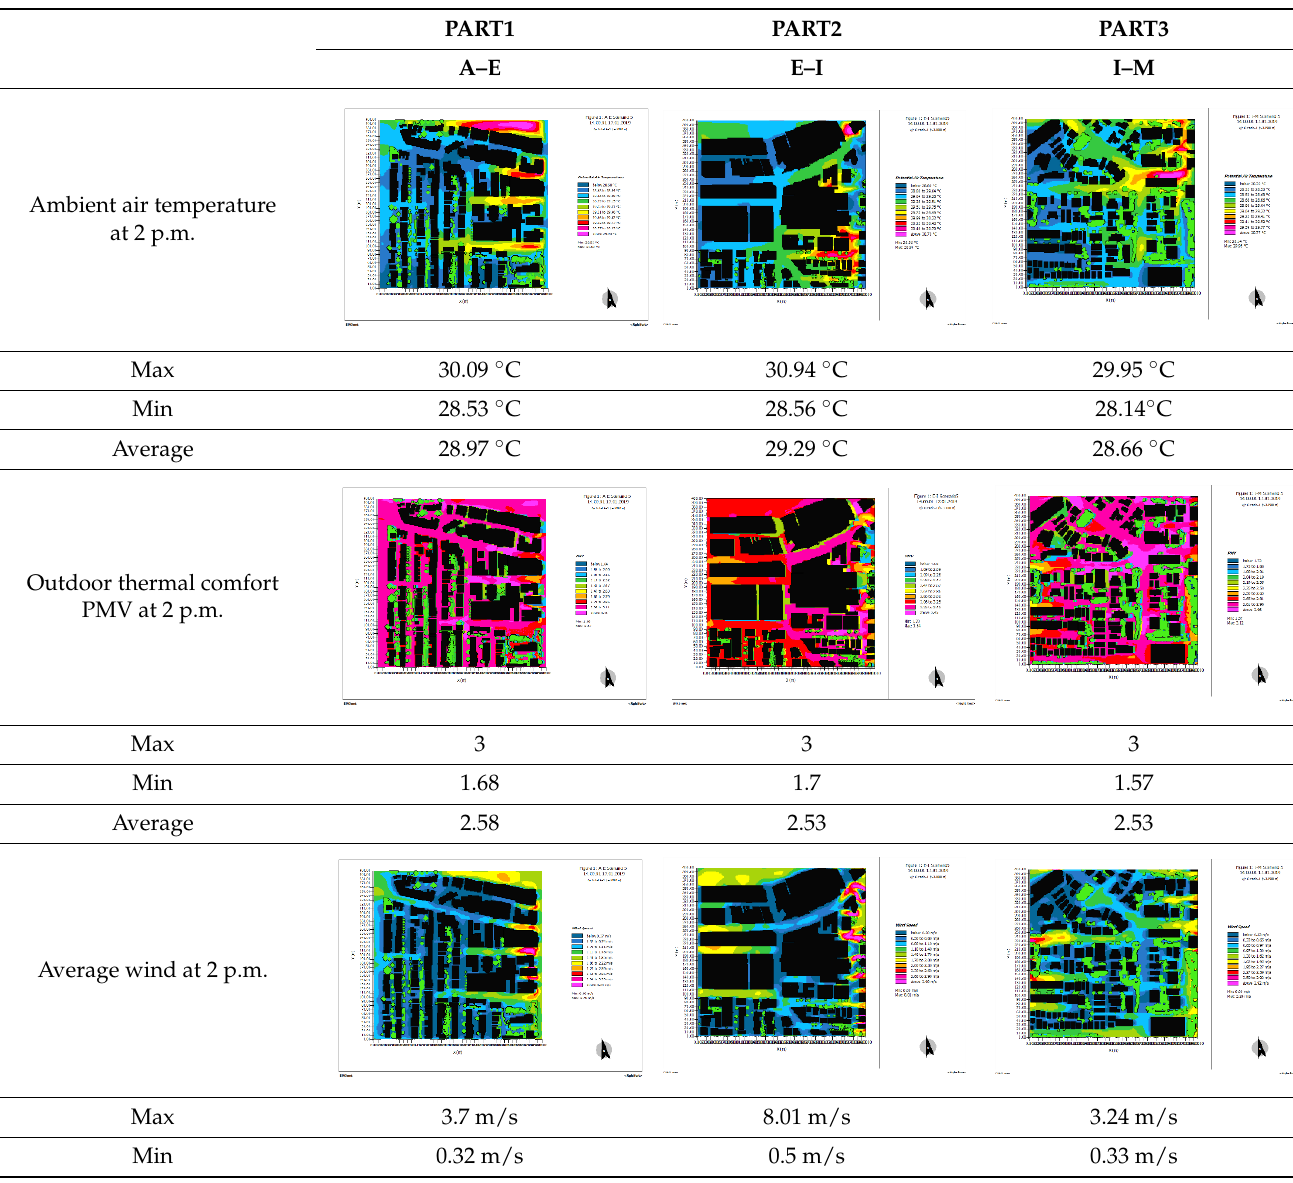
Table 12. Scenario five ambient air temperature, outdoor thermal comfort, and wind speed distri- bution maps in all parts at 2 pm.